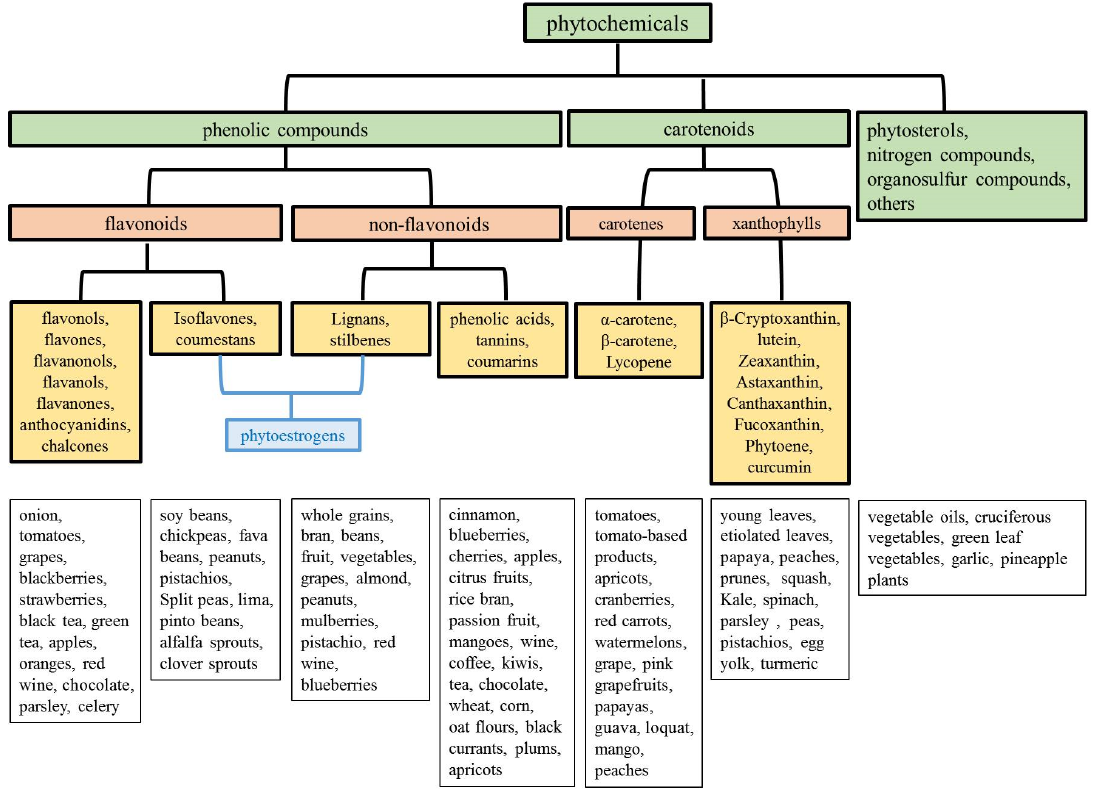
Figure 1. Classification and dietary sources of phytochemicals.